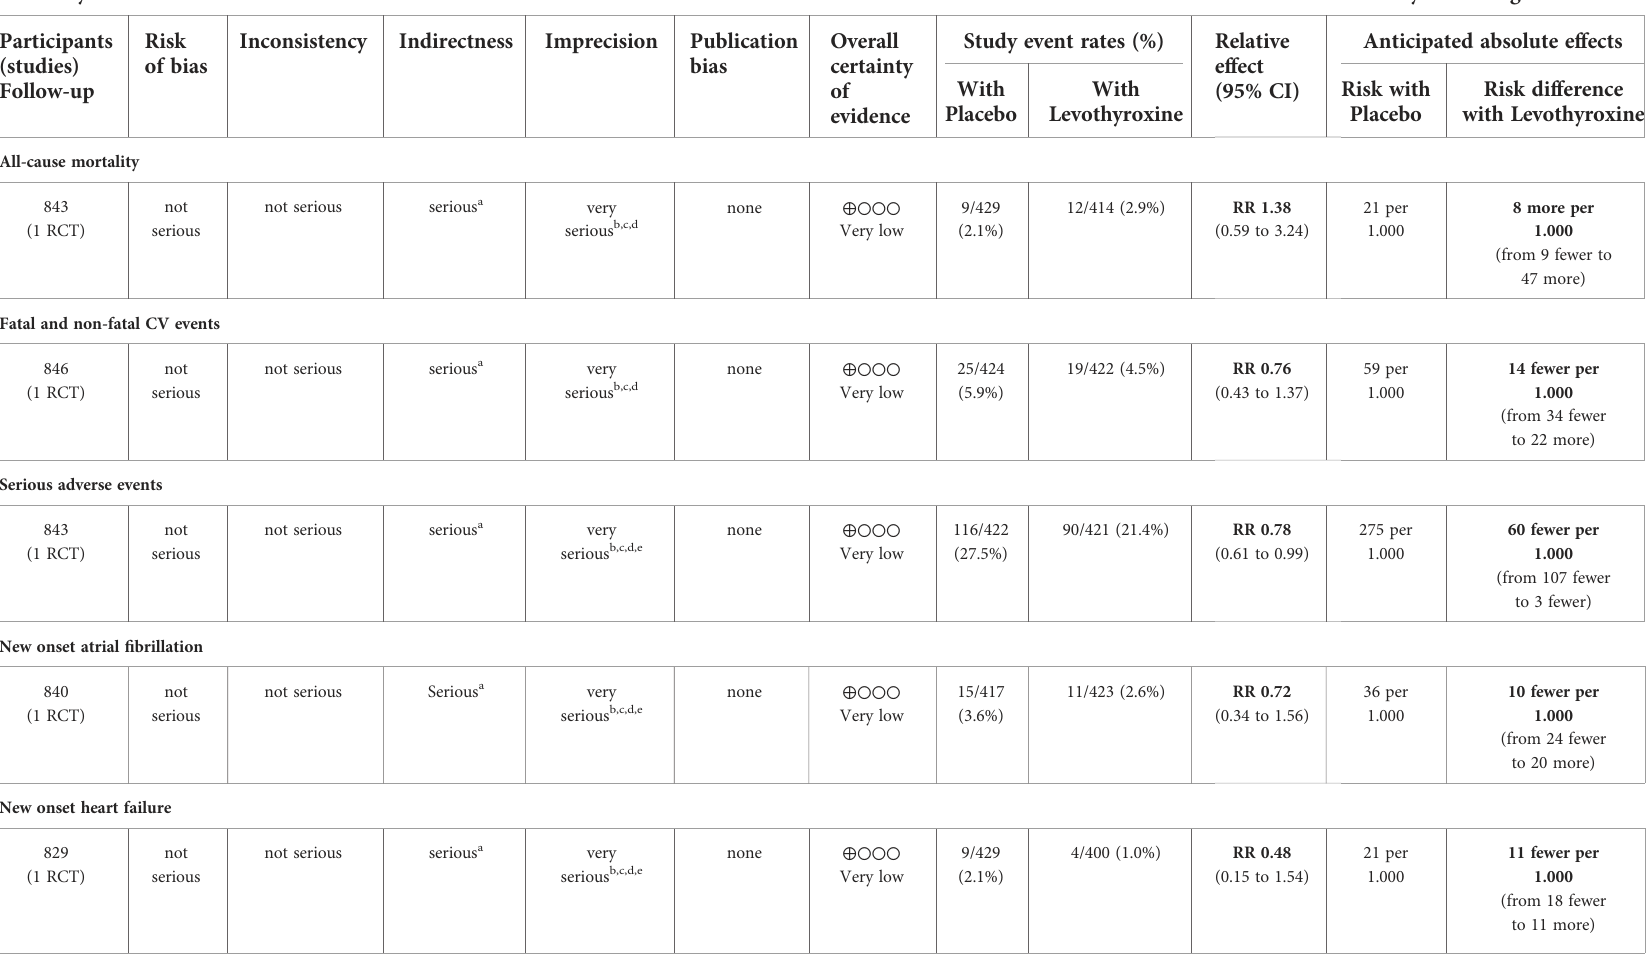
TABLE 3 Levothyroxine versus placebo for improving CV outcomes in patients with SCH and CHF (Zijlstra LE, et al.,